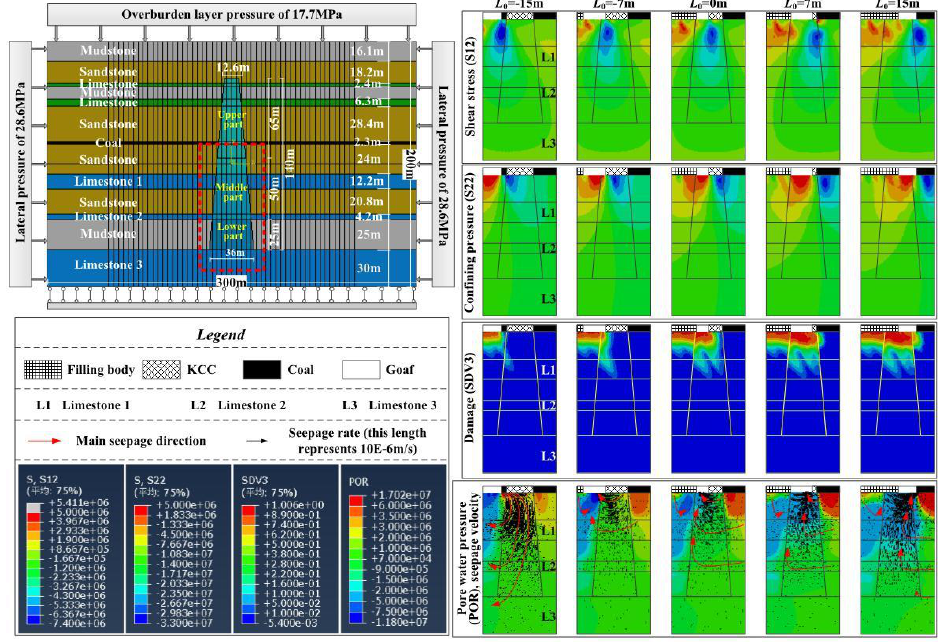
Figure 12. Numerical calculation model and results.